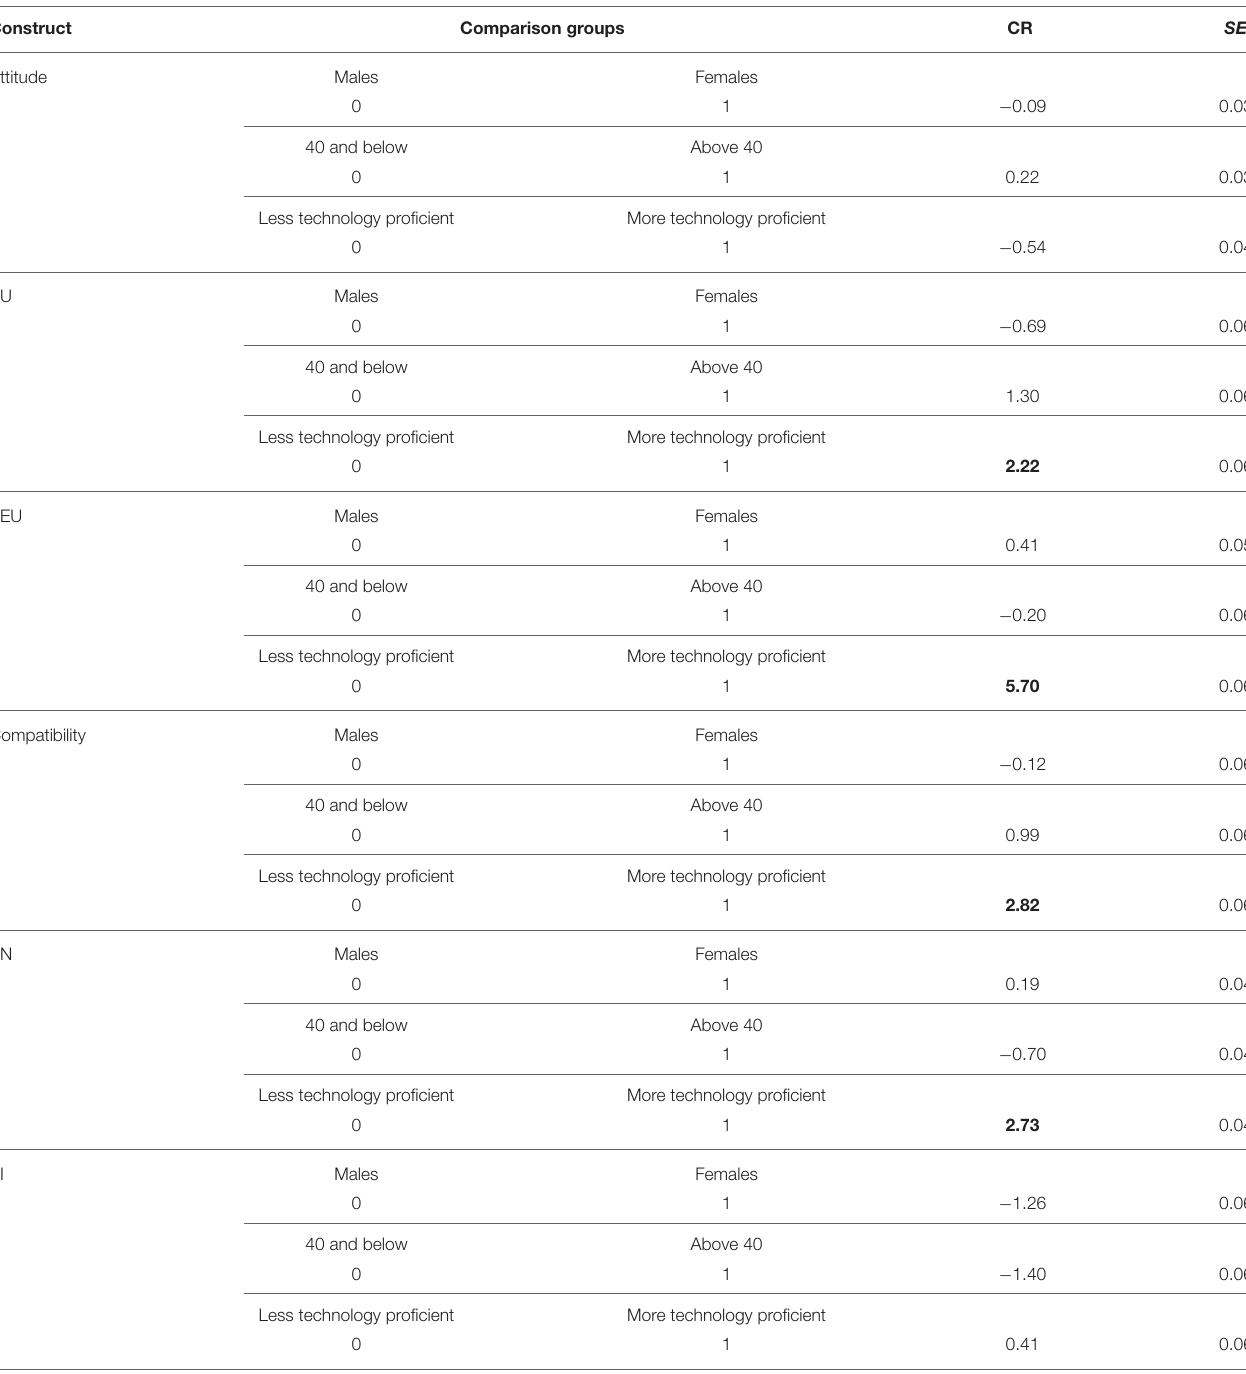
TABLE 4 | Latent mean